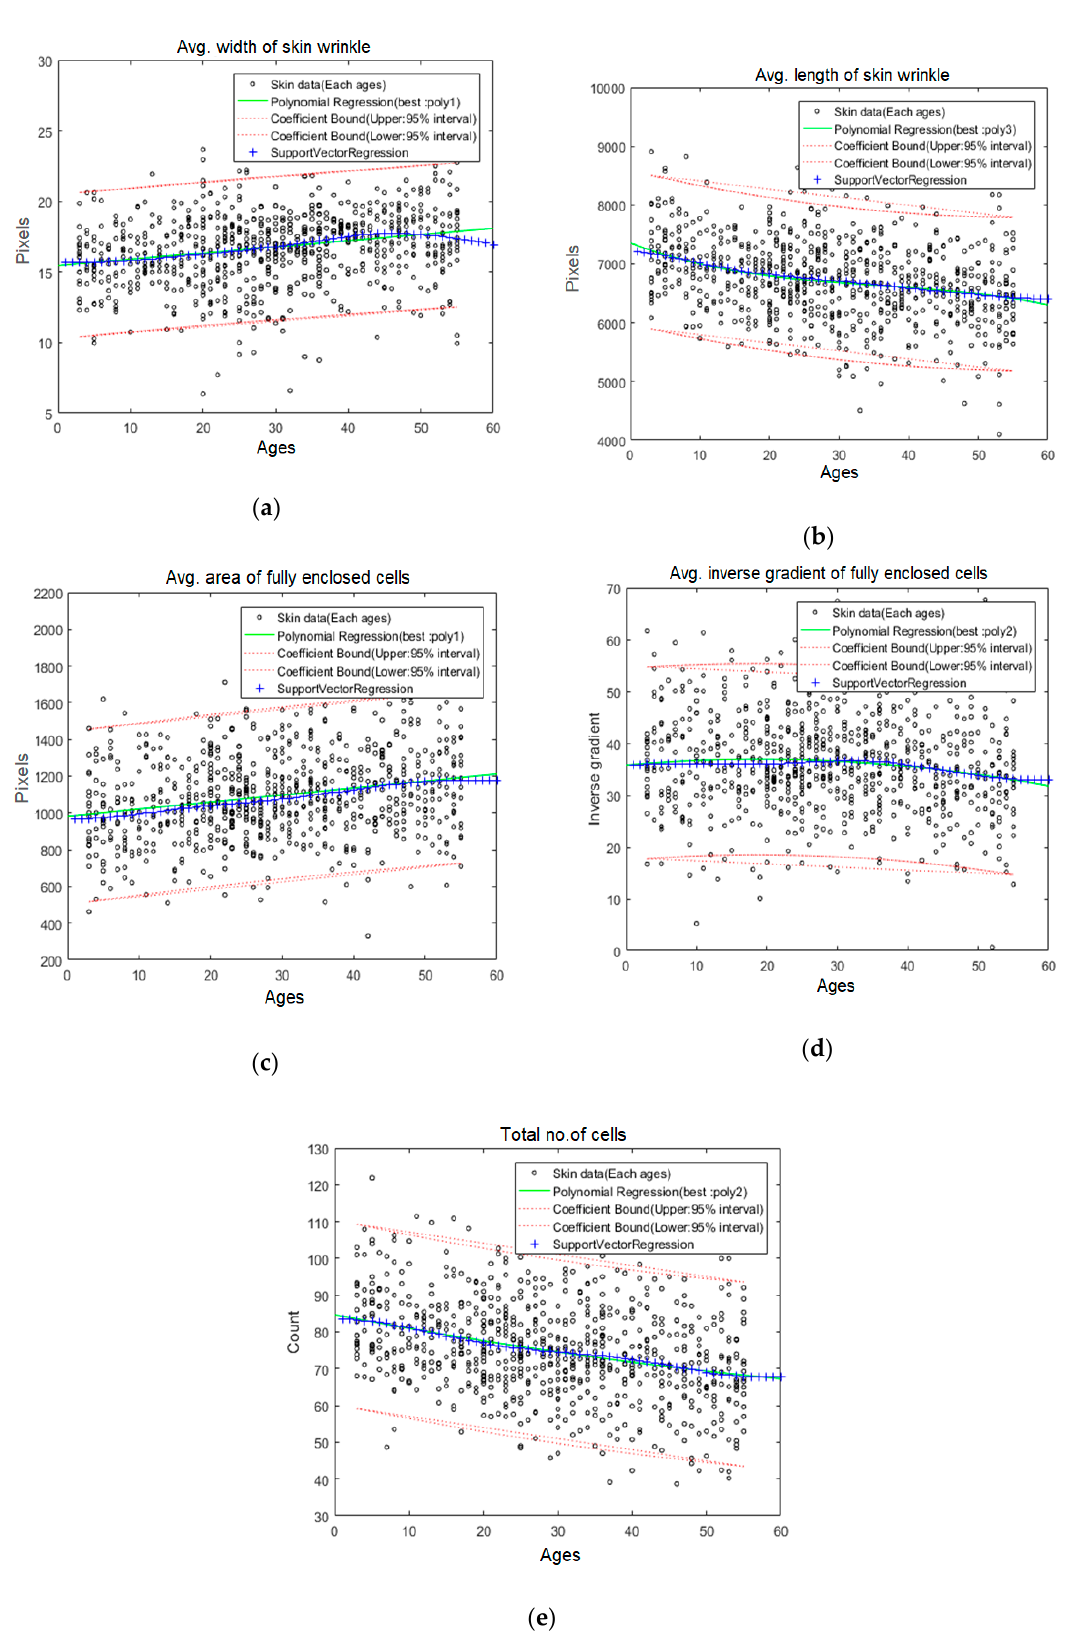
Figure 13. Neck skin texture aging trend estimation using polynomial regression and SVR—( a ) average width trend of neck wrinkle; ( b ) average length trend of neck wrinkle; ( c ) average area trend of fully enclosed neck cells; ( d ) average inverse gradient trend of fully enclosed neck cells; (e) trend of the total number of neck cells.